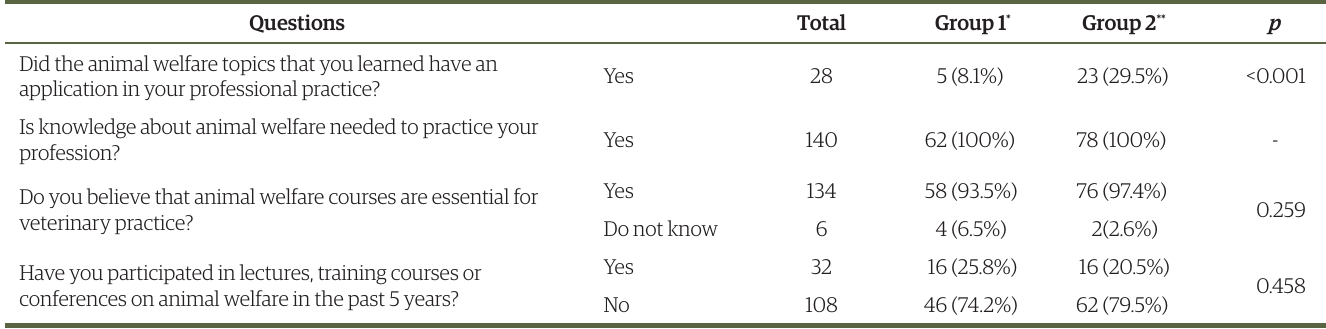
Table 4. Perception of the need for/relevance of animal welfare for the profession and participation in events per group.